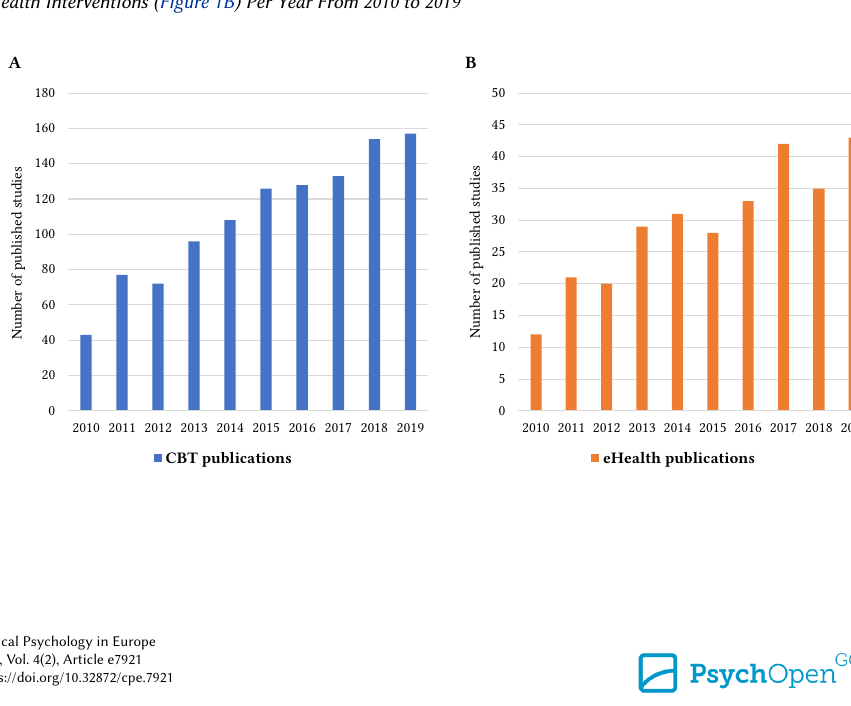
Treatment Approach